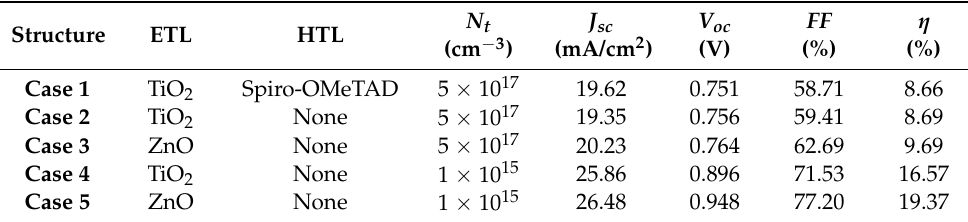
Table 5. Comparison between five different cases of hybrid hetero-homojunction-based PSCs.